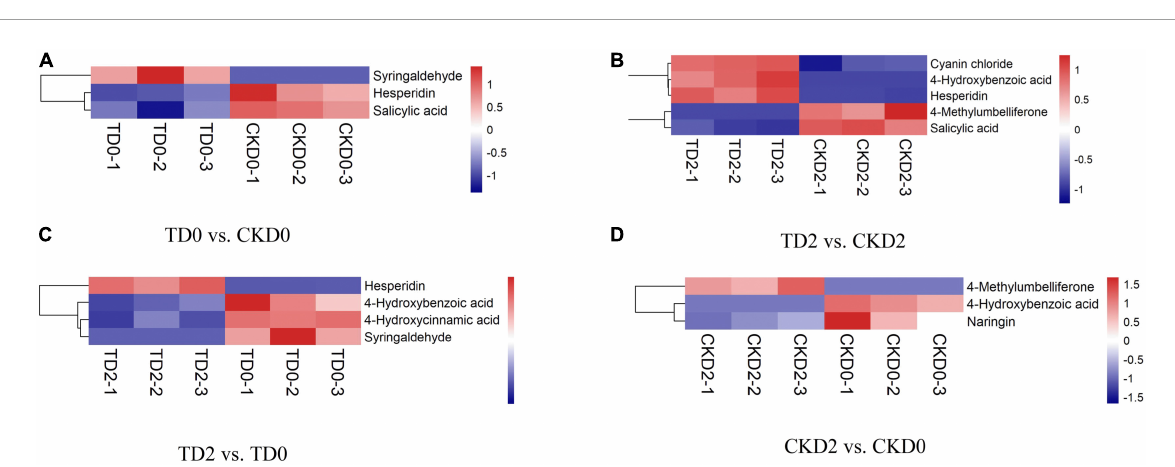
the PPO activity, but the inhibitory effect between different treatment groups was not significant. The results showed that the POD activity of the treatment and control groups